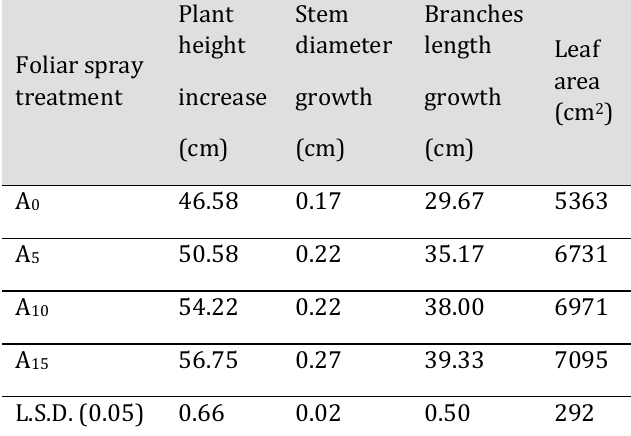
Table 2. Effect of foliar fertilization on growth characteristics of pear seedling.